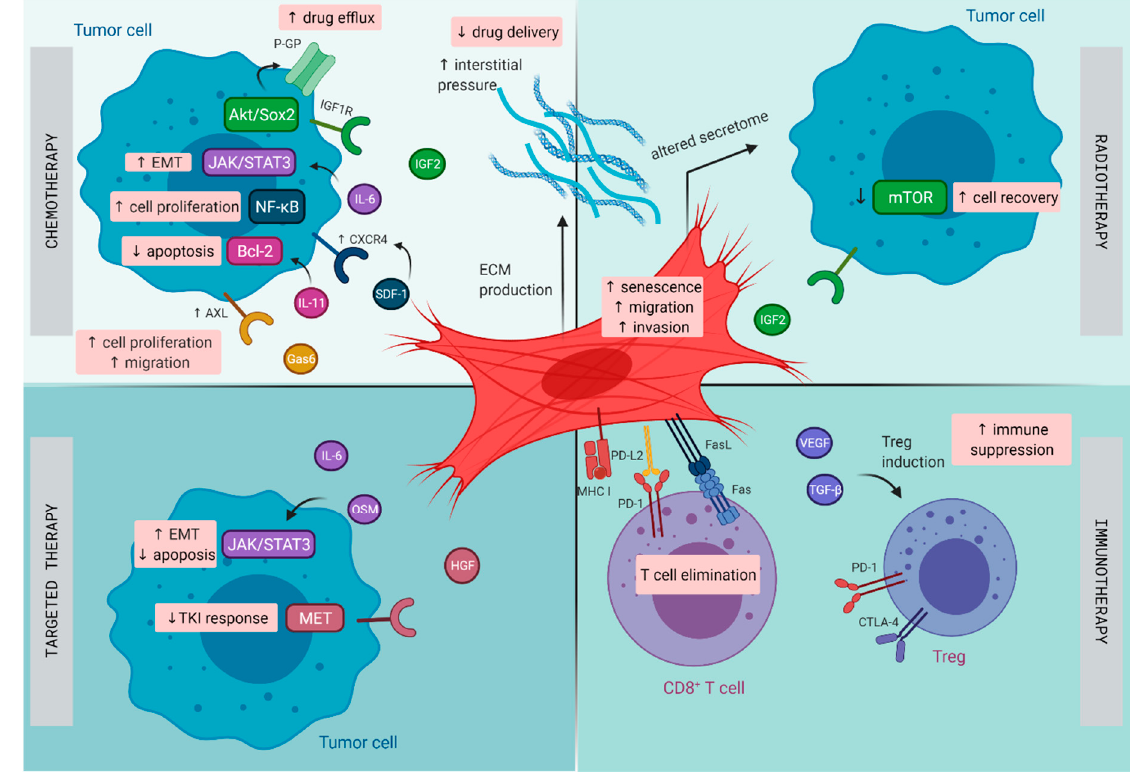
Figure 1. Mechanisms of therapy resistance in lung cancer orchestrated by cancer -associated fibroblasts (CAFs): Schematic illustration on how CAFs diminish the effect of chemotherapy, radiotherapy, targeted therapy, and immunotherapy in lung cancer. CTLA-4, cytotoxic T lymphocyte-associated protein 4; CXCR4, C-X-C chemokine receptor type 4; ECM, extracellular matrix; EMT, epithelial–mesenchymal transition; FasL, Fas ligand; Gas6, growth arrest specific-6 protein; HGF, hepatocyte growth factor; IGF1R, insulin-like growth factor 1 receptor; IGF2, insulin-like growth factor 2; IL, interleukin; MHC I, major histocompatibility complex I; OSM, oncostatin-M; PD-1, programmed cell death 1; PD-L2, programmed cell death ligand 2; P-GP, P-glycoprotein; SDF, stromal cell-derived factor; TGF- β , transforming growth factor- β ; TKI, tyrosine kinase inhibitor; Treg, regulatory T cell; VEGF, vascular endothelial growth factor.